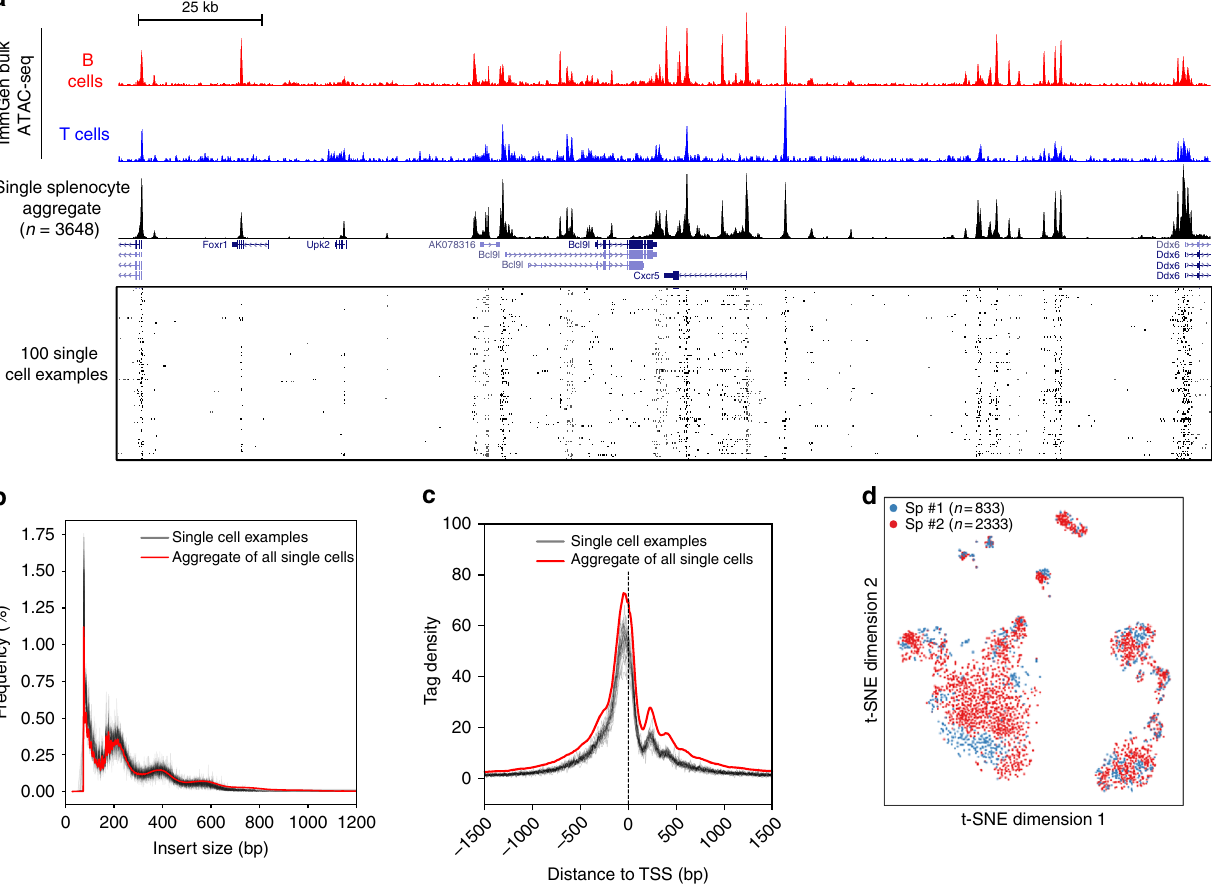
Fig. 3 Plate-based scATAC-seq applied to over 3000 mouse splenocytes. a UCSC genome browser tracks displaying the signal around the Cxcr5 gene locus from the aggregate of all single cells in this study. Bulk ATAC-seq pro fi les from the ImmGen consortium are also shown. Randomly selected 100 single cell pro fi les are show below the aggregated pro fi le. b , c Insert size frequencies b and sequencing read distributions across transcriptional start sites c of libraries from the aggregated data (the red line) and individual single cells (grey lines, 24 examples are shown). d A two-dimensional projection of the scATAC-seq data using t-SNE. Colours represent two different batches, showing excellent agreement between batches. Sp,